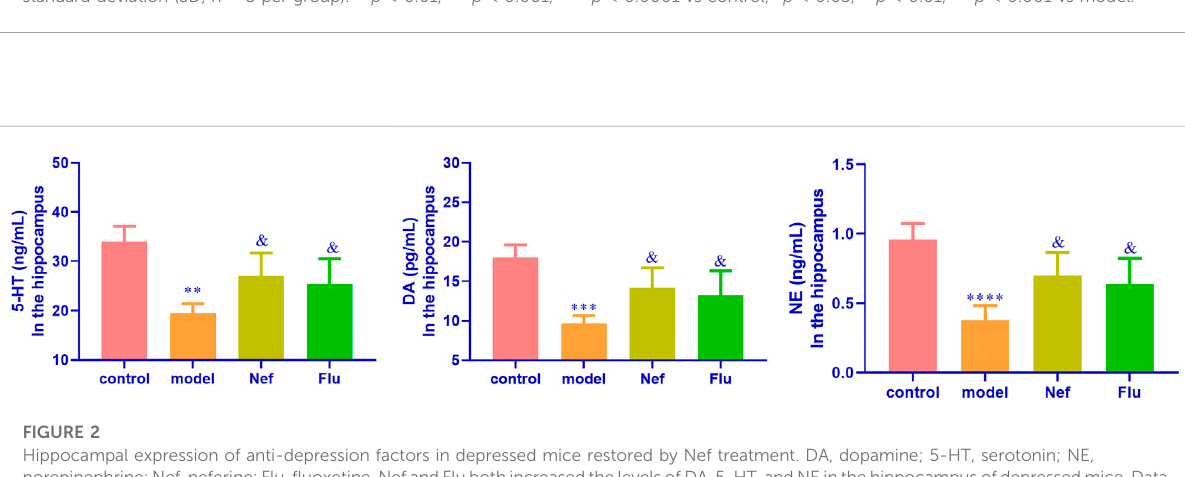
Nefimprovesbehavioraldepressionsymptomsinmicemodelsofdepression.TST,tailsuspensiontest;FST,forcedswimmingtest;SPT,sucrose preference test; Nef, neferine; Flu, fl uoxetine. Nef and Flu both improved the depressed behavior of depressed mice. Data are presented as mean ± standard deviation (SD; n = 5 per group). ** p < 0.01, *** p < 0.001, **** p < 0.0001 vs control; & p < 0.05, && p < 0.01, &&& p < 0.001 vs model.